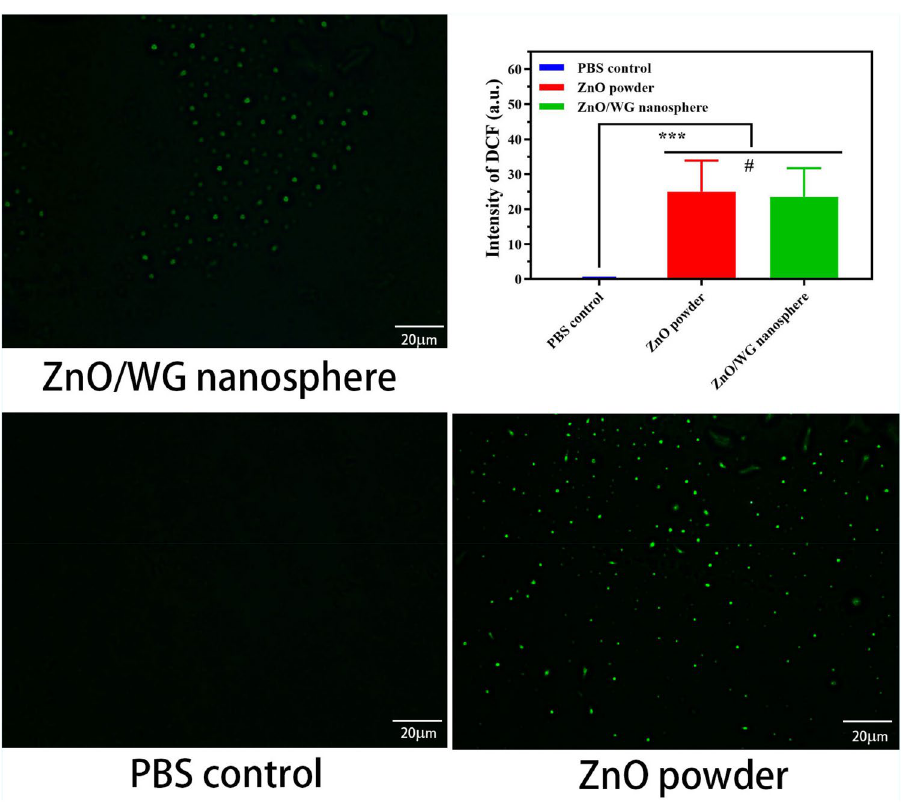
Figure 7. The results of ROS determination (Scale bar:20 μm, Results are expressed as the mean ± SD; corresponding DCF fluorescence value *** p < 0.005, # p >